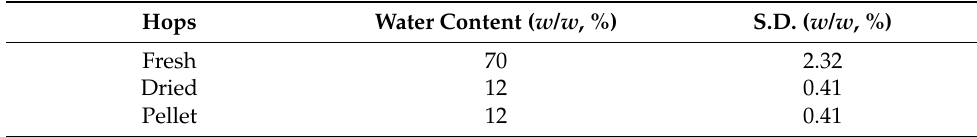
Table 1. Hops water